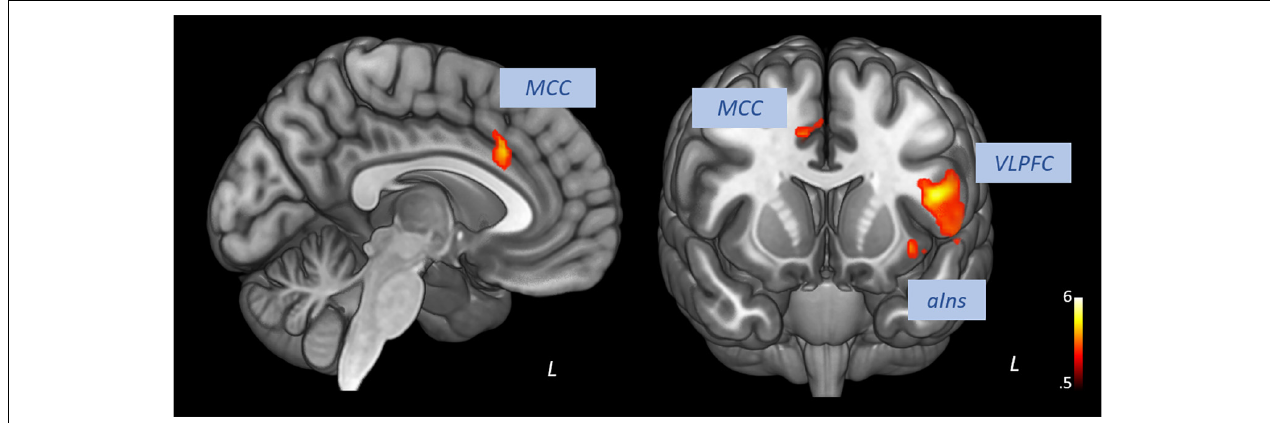
FIGURE 1 | Correlation of heart rate variability changes with changes of functional connectivity of the prefrontal cortex (voxel-level: p < 0.005 uncorr., cluster-level: p < 0.05 FDR-corrected). MCC, middle cingulate cortex; VLPFC, ventral lateral prefrontal cortex; aIns, anterior insula. TABLE 1 | Correlation of prefrontal connectivity changes with heart rate variability changes (voxel-level: p < 0.005 uncorr., cluster-level: p < 0.05 FDR-corrected). Region Left/Right Cluster size Brodmann’s area MNI coordinates t x y z Middle cingulate gyrus 205